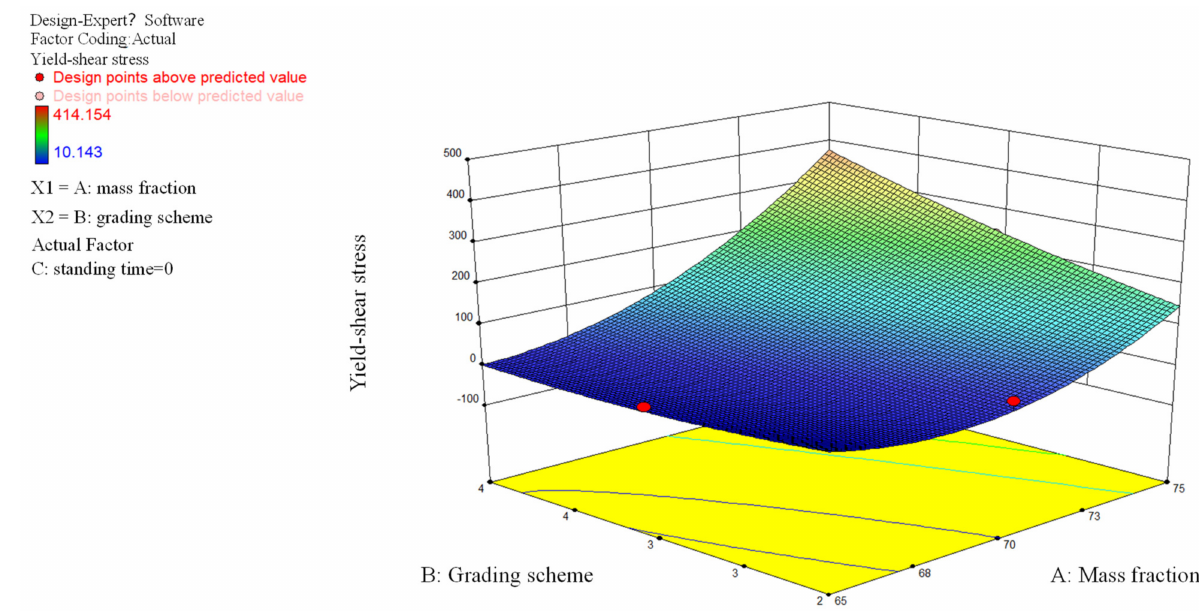
Figure 15. D = f(A,B) response surface diagram.